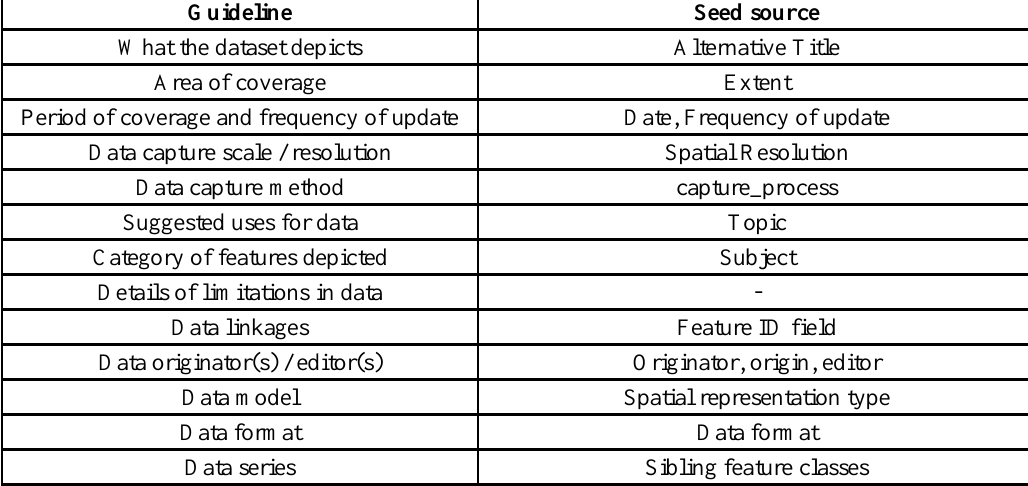
Table 4. Guidelines for completing abstract content (adapted from recommendations published by Gigateway at